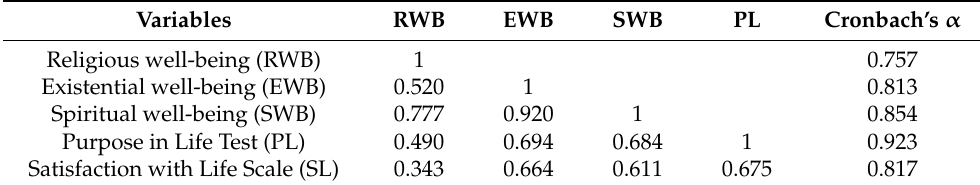
Table 3. Correlation and internal consistency of the